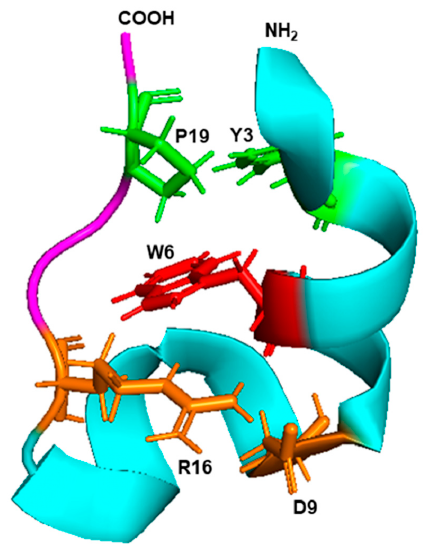
Figure 8. Trp cage fold. The 3D structure (PDB: 2JOF) of the 20 amino acid-long Trp cage peptide of the sequence DAYAQWLKDGGPSSGRPPPS was retrieved from the NCBI structure bank and shown in the PyMol presentation. The amino- and carboxy-terminal ends are marked as such, and the single α -helix and the β -strand are colored in cyan and magenta, respectively. The central Trp (W6) is red, the Y3–P9 interacting pair is green, and the D9–R16 interacting pair is orange, as detailed in the text (Section 6.3).